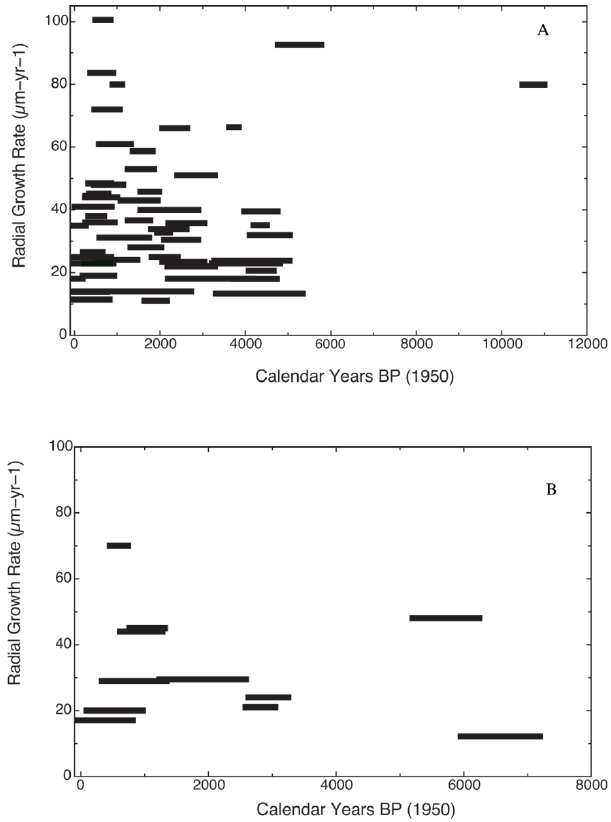
Fig. 3. (A) Upper panel: Hawaiian Gerardia longevity (calendar years BP) and average radial growth rate (µmyr − 1 ) ; and (B) lower panel: equivalent plot for Line Islands